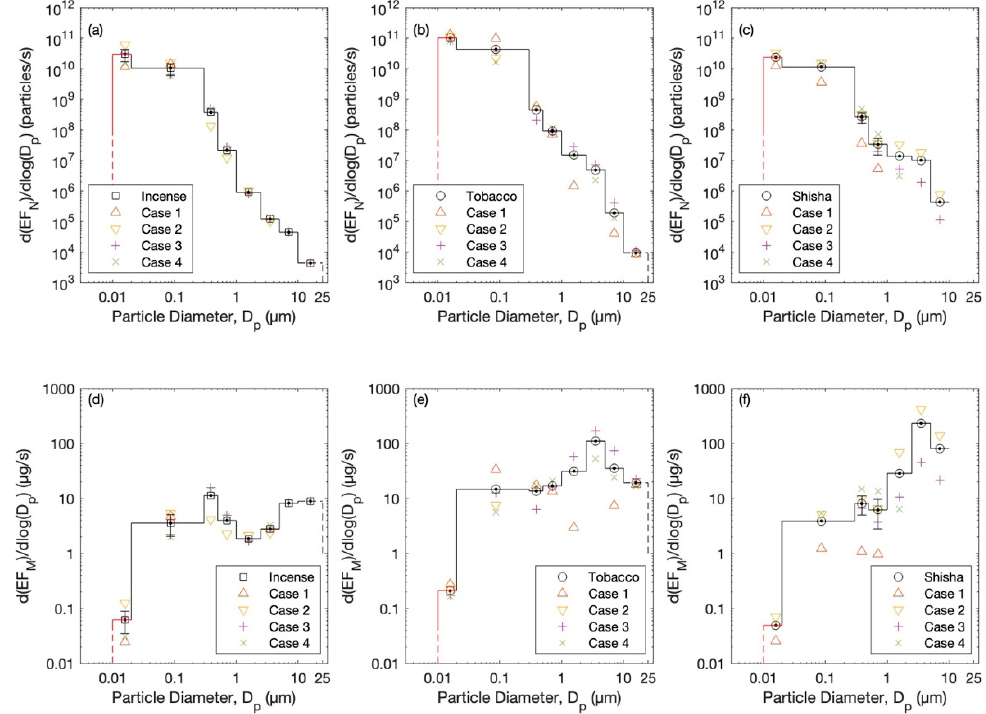
Figure 6. Mean emission rates in the form of particle number size distributions during each case of the different scenarios: ( a ) incense stick burning, ( b ) cigarette smoking, and ( c ) shisha smoking. ( d – f ) The corresponding mean particle mass size distributions.